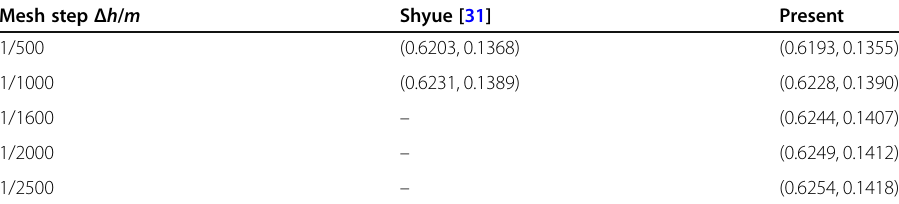
Table 2 Grid convergence study of position of the cylinder mass center at the final stopping time t = 0.30085 s